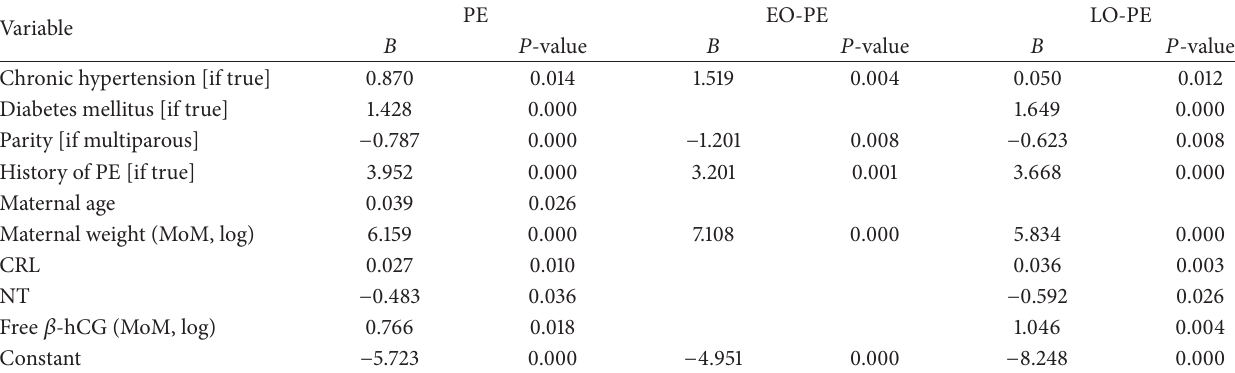
Table2:LogisticregressionmodelsforpredictionofPE,EO-PEandLO-PEbymaternalcharacteristicsandaneuploidyscreeningbiomarkers.